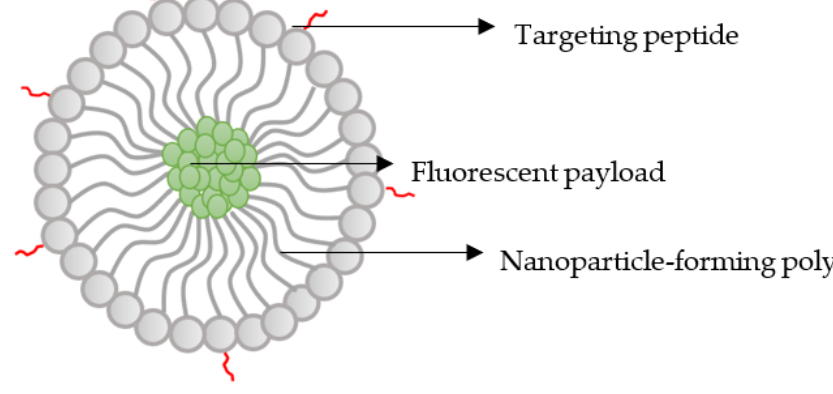
Figure 1. Illustration of a peptide-functionalised NPs loaded with a drug.